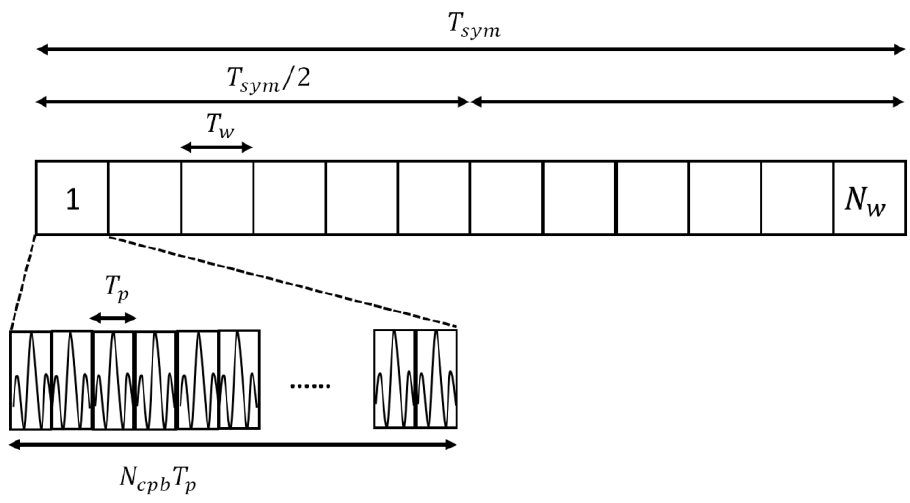
Figure 3. Signal transmission example in the case of the burst pulse option.